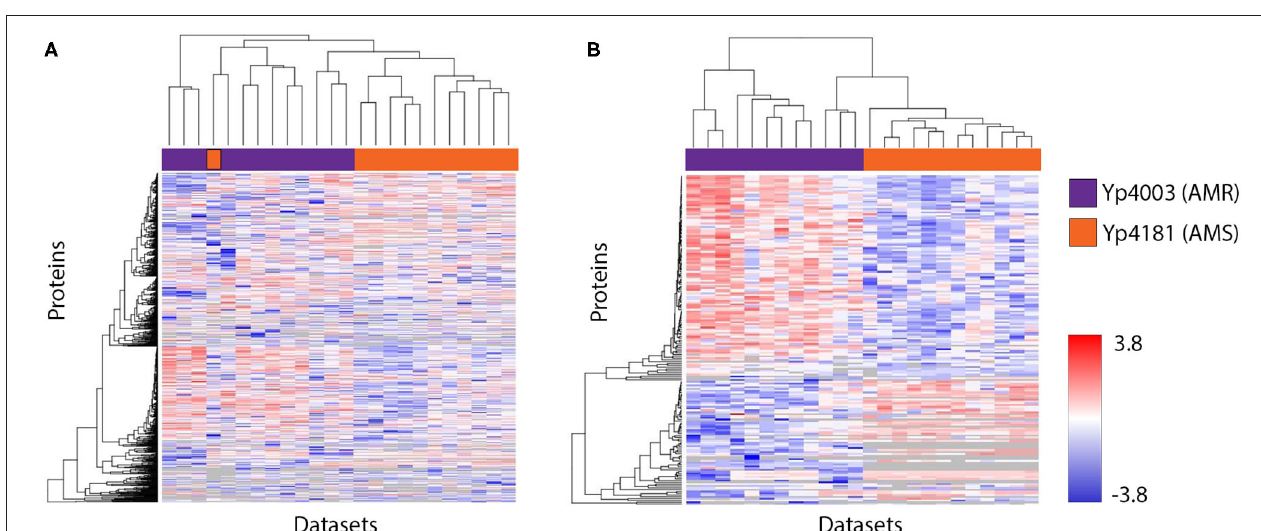
FIGURE 4 | Visualization of protein expression patterns shows bidirectional protein expression changes in Y. pestis strain pair Yp4003/Yp4181. (A) includes all proteins observed in our analyses at the early time point (no streptomycin). (B) includes the subset of proteins found to be significantly differentially expressed between AMR and AMS strains, as well as those found to be present/absent in this comparison. Proteins are represented in individual rows along the y-axis, and datasets are represented as individual columns along the x-axis. In all heat maps, hierarchical clustering was used to group proteins with similar expression trends. Expression levels are shown on a scale from blue (low) to red (high). Gray indicates the protein was not observed in a dataset.